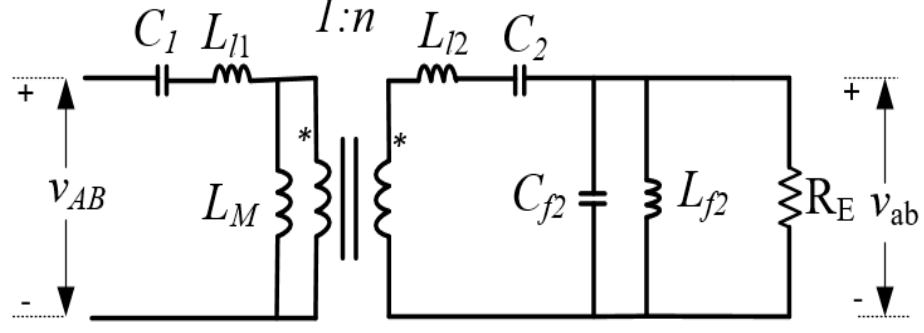
Figure 1. Equivalent circuit of the LC-LC 2 compensation network.